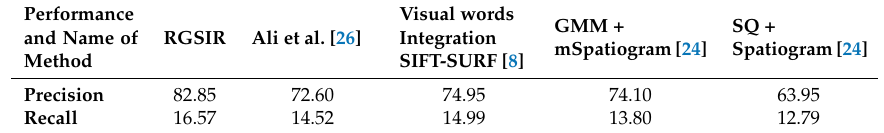
Table 3. Comparison of Average Retrieval Precision and Recall when using Corel-1.5K image dataset.